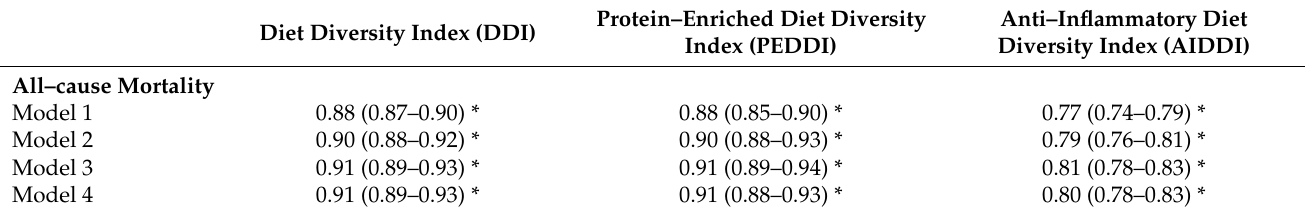
Table 2. Associations of types of Dietary Diversity, Dietary Pattern with depressive symptoms among whole sample.